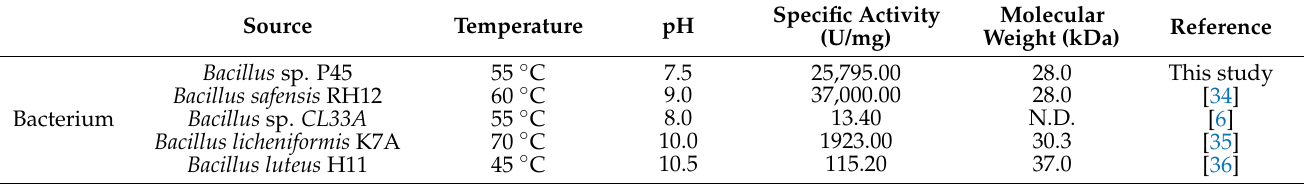
Table 2. Optimum temperatures and pH values for some proteases from fungi and bacteria.